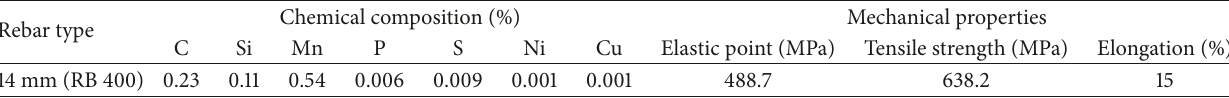
Table 2: Chemical composition with some physical characteristics of the steel bars used in the